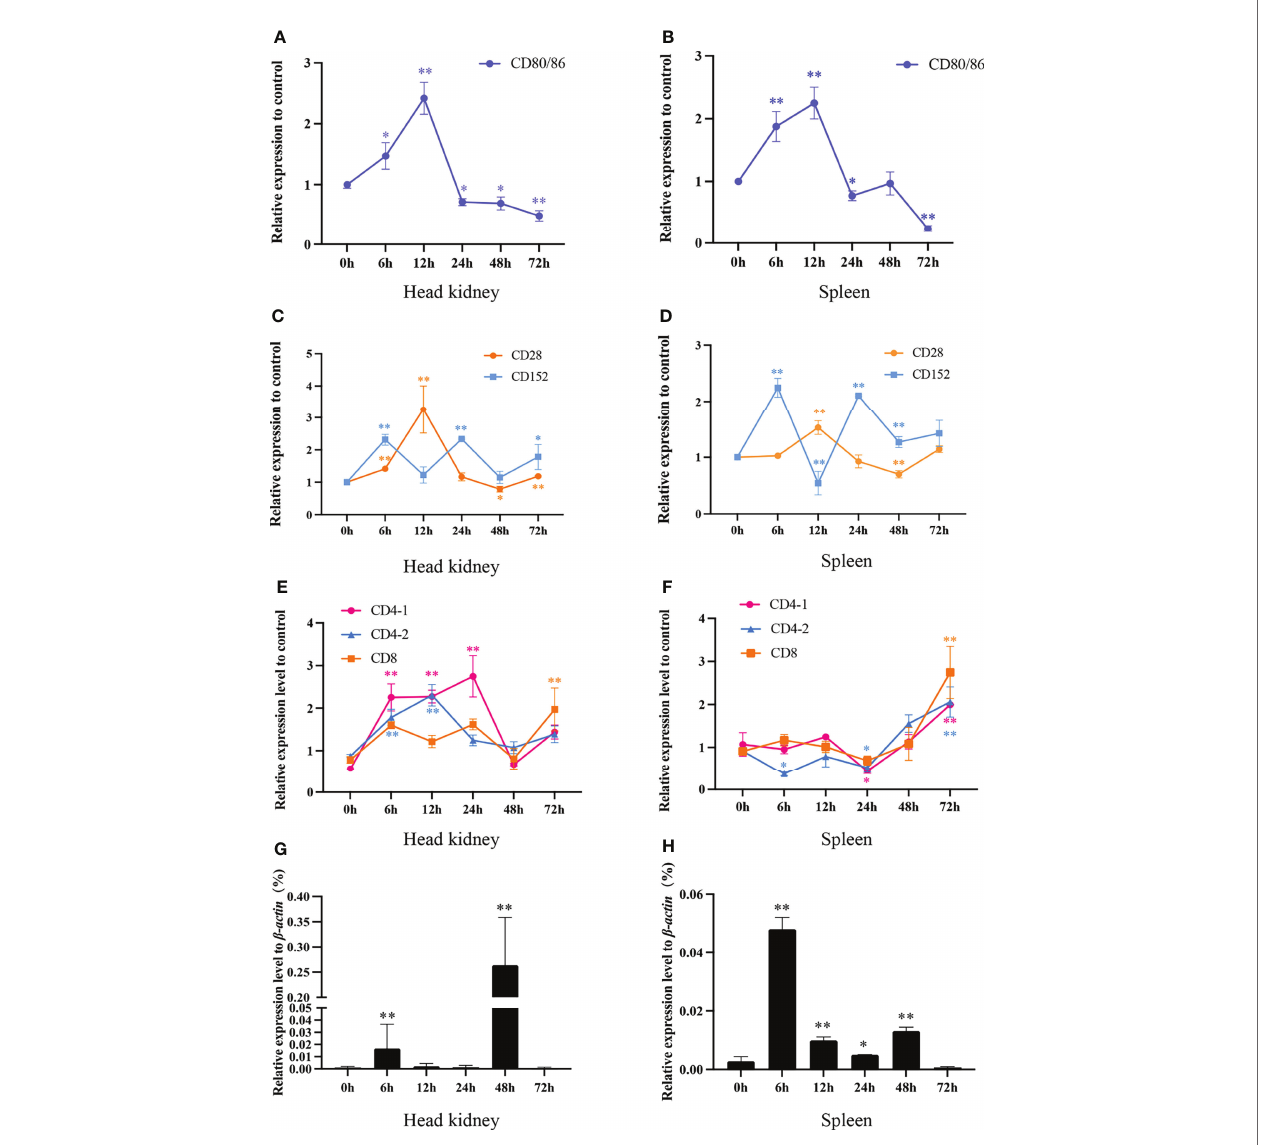
FIGURE 10 | The mRNA expression levels of CD80/86 , CD28 , CD152 , CD4-1 , CD4-2 , and CD8 genes in grass carp head kidney and spleen following the A. hydrophila infection. (A) The mRNA expression level of CD80/86 in the head kidney. (B) The mRNA expression level of CD80/86 in the spleen. (C) The mRNA expression levels of CD28 and CD152 in the head kidney. (D) The mRNA expression levels of CD28 and CD152 in the spleen. (E) The mRNA expression levels of CD4-1 , CD4-2 , and CD8 in the head kidney. (F) The mRNA expression levels of CD4-1 , CD4-2 , and CD8 in the spleen. (G) The expression level of 16s RNA in the head kidney. (H) The expression level of 16s RNA in the spleen. The fold changes of CD80/86 , CD28 , CD152 , CD4-1 , CD4-2 , and CD8 were calculated by comparing the stimulated group with the control group (de fi ned as 1) using the 2 − DD Ct method. The expression level of 16s RNA was analyzed by qPCR and normalized against grass carp b -actin using the 2 − D Ct method. The data represent the mean ± SEM for 4 individual fi sh. The p -value was calculated by one-way ANOVA with the LSD post hoc test (* p < 0.05, ** p <